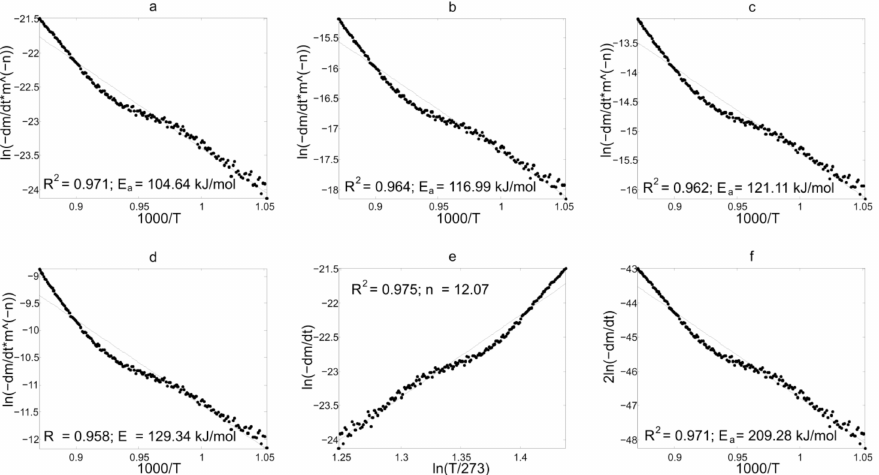
Figure 7. Results of processing of the charcoal gasification TG curve at a heating rate of 5 K min − 1 by different models: ( a ) n = 0; ( b ) n = 0.5; ( c ) n = 2/3; ( d ) n = 1; ( e ) diffusion model; ( f ) pore- diffusion model.